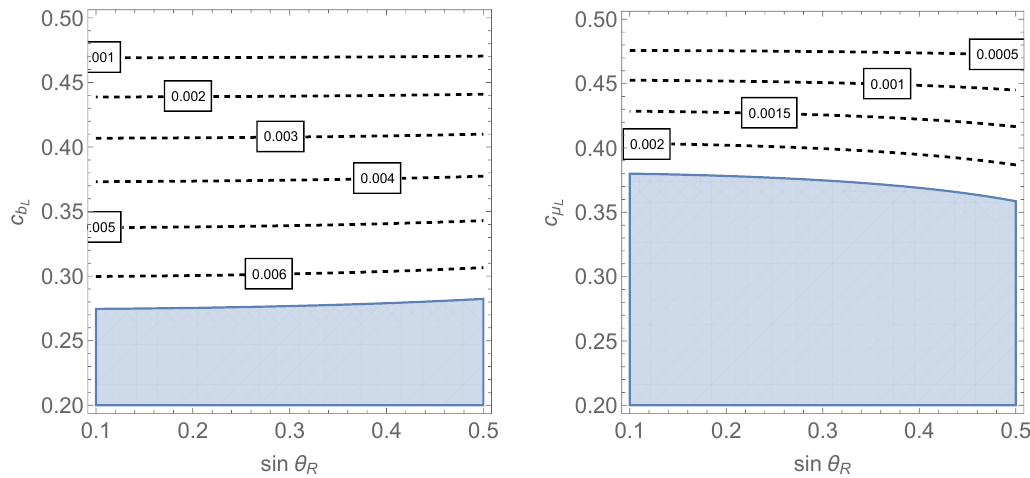
Figure 8 . Left panel: contour lines of (cid:14)g Z sin (cid:18) (cid:6) = 0 : 72. The white region is allowed by electroweak precision data at the 95% CL.